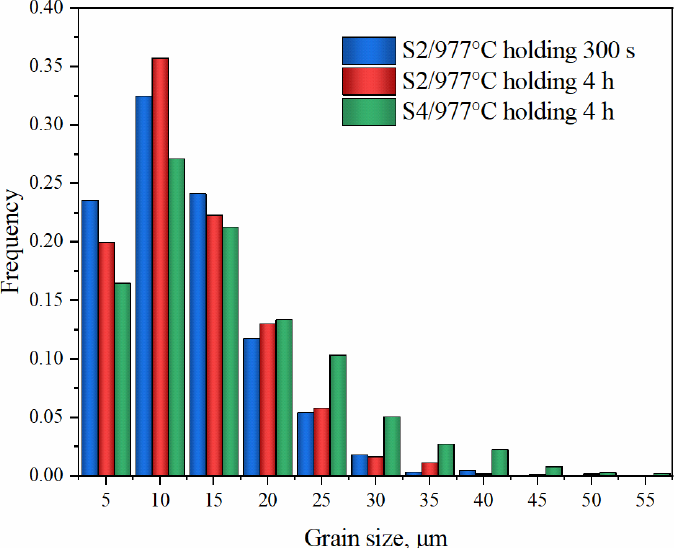
Figure 8. Comparison of austenite grain size-frequency distributions of S2 at the start of carburization and S2 and S4 after carburization at 977 °C.